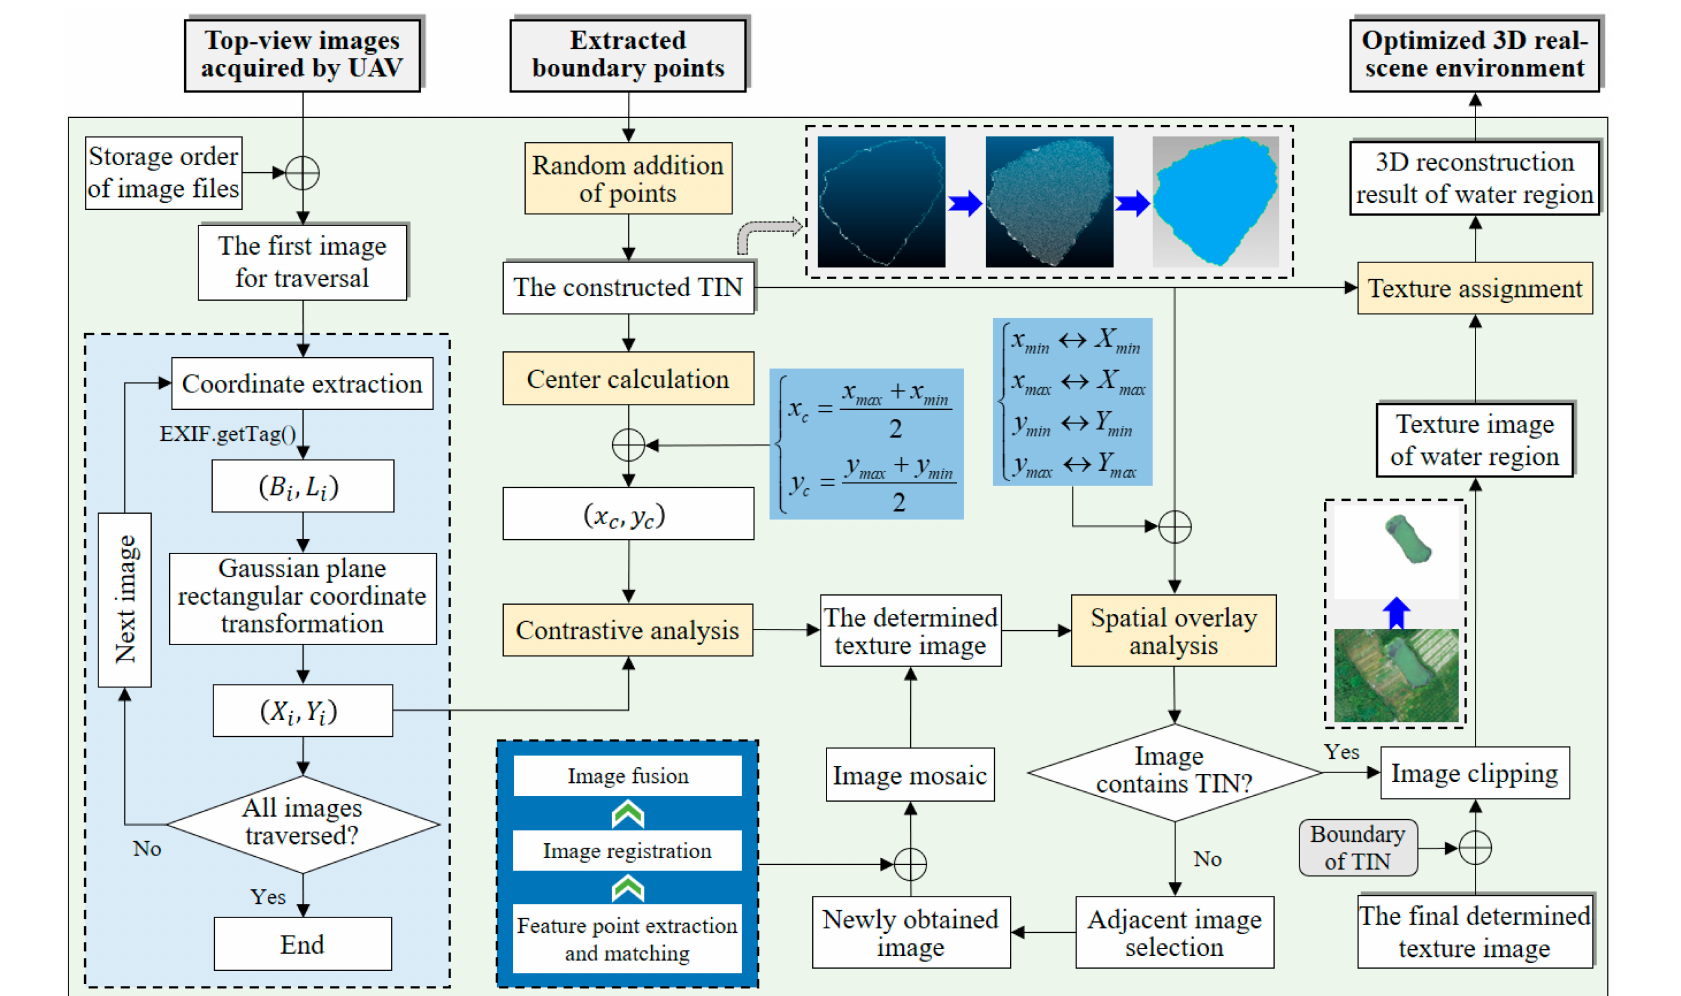
Figure 4. The flowchart of the procedure of TIN reconstruction and texture mapping of water